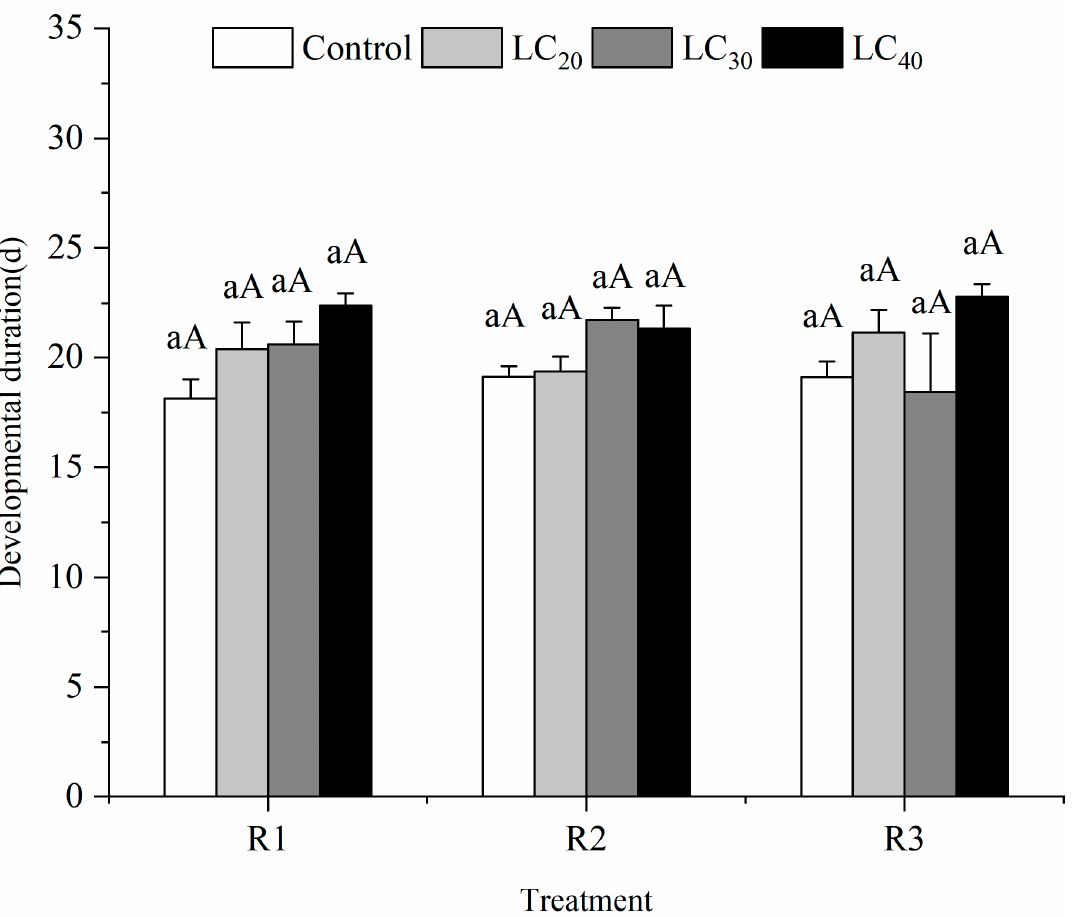
Figure 4. The development duration (mean ± SE) of Tetrastichus howardi at different concentrations of indoxacarb was treated with three methods. R1 (Routes of exposure 1) is adult exposure to pesticide residues on the glass tube, the LC 20 , LC 30 , LC 40 , and water control were used. R2 (Routes of exposure 2) is adult exposure to pesticide residues on the host, the LC 20 , LC 30 , LC 40 , and water control were used. R3 (Routes of exposure 3) is larval exposure to pesticides through host exposure, the LC 20 , LC 30 , LC 40 , and water control were used. Means in the same routes of exposure followed by different lowercase letters represent a significant difference in different concentrations of pesticide on T. howardi. Means in the same concentrations followed by the same uppercase letter were not significantly different in different routes of exposure based on Tukey’s multiple range test at the 5% level.